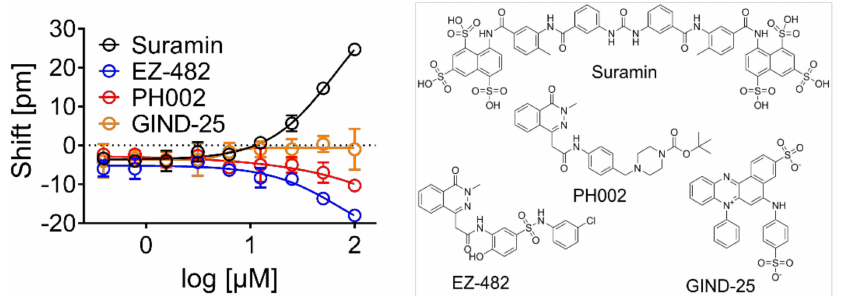
Figure 2. Selection of suramin as positive control. Available ApoE4 modulators, as well as suramin, were tested by concentration response on the Corning Epic against ApoE4. Only suramin positively shifted the wavelength, suggesting binding, whereas negative shifts were observed for PH002 and EZ-482, which may indicate the precipitation of compounds or binding to the reference surface of the biosensor. No binding was detected for GIND-25 at the used concentrations. The data are expressed as the mean of three independent experiments; standard deviation (SD) is represented by the error